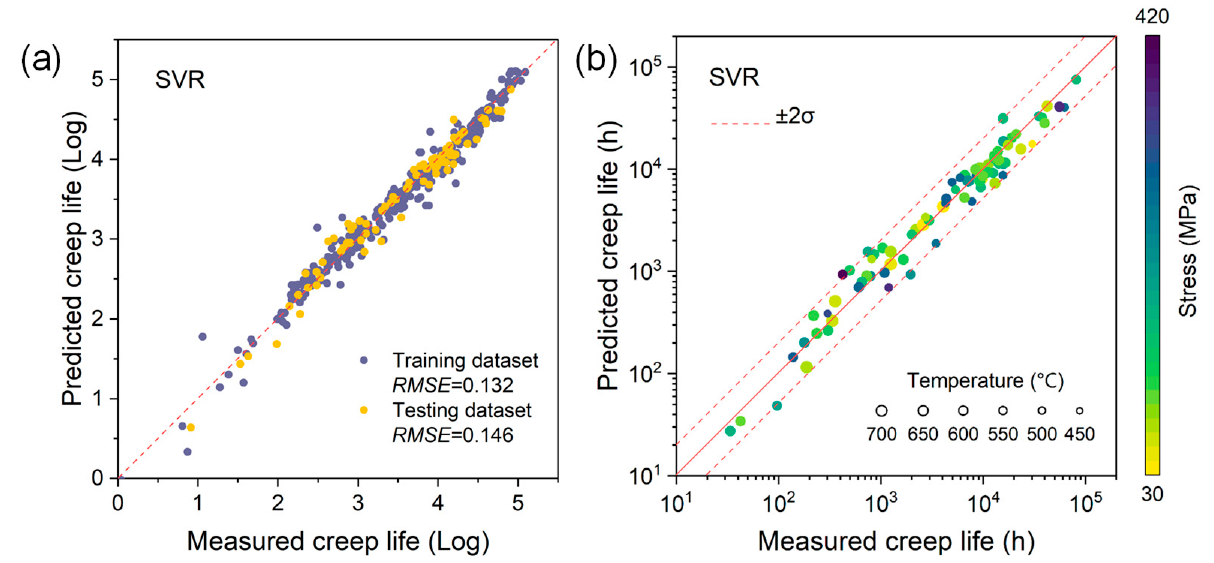
Figure 8. Prediction results of creep rupture life by SVR model: ( a ) Training and prediction results of creep life in log scale; ( b ) Predicted creep life vs. measured creep life.